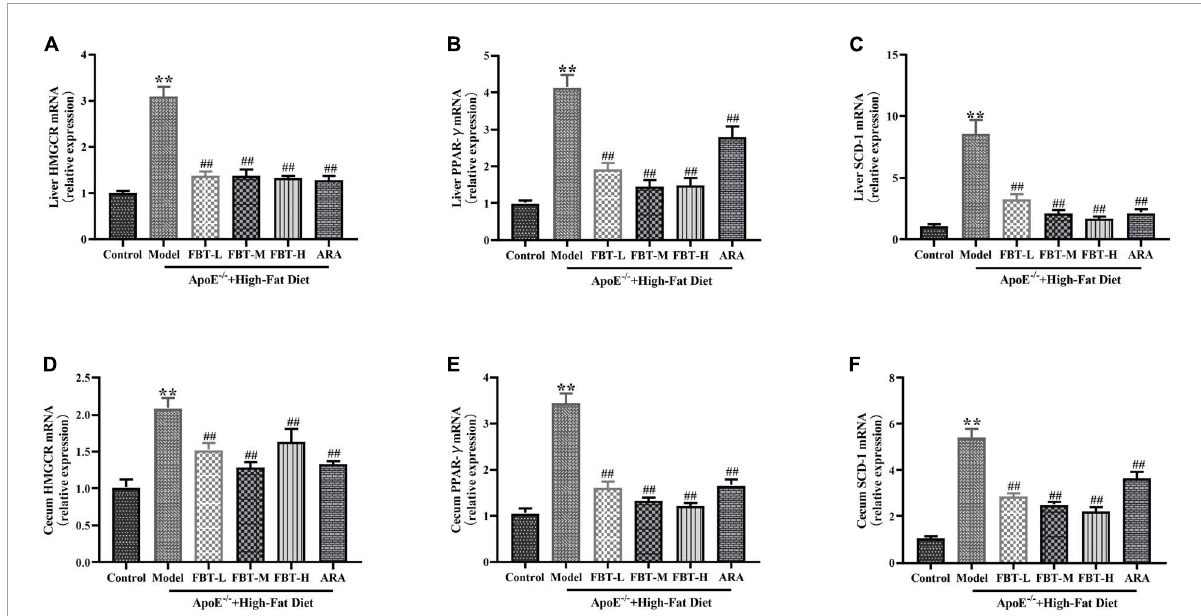
FIGURE8 Effects of FBT on factors related to lipid synthesis in the cecum and liver of NAFLD mice. (A) HMGCR in the liver was decreased in NAFLD mice after treatment with FBT; (B) PPAR- γ in the liver was decreased in NAFLD mice after treatment with FBT; (C) SCD-1 in the liver was decreased in NAFLD mice after treatment with FBT; (D) HMGCR in the cecum was decreased in NAFLD mice after treatment with FBT; (E) PPAR- γ in the cecum was decreased in NAFLD mice after treatment with FBT; (F) SCD-1 in the cecum was decreased in NAFLD mice after treatment with FBT. N = 12. ** P < 0.01 vs. control group. ## P < 0.01 vs. model